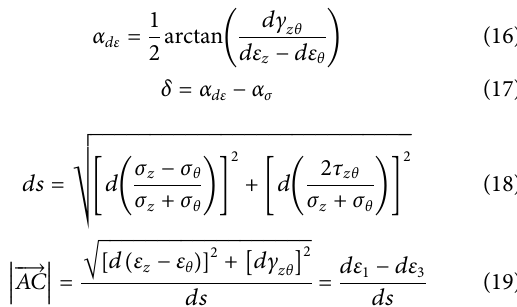
Frontiers in Earth Science |